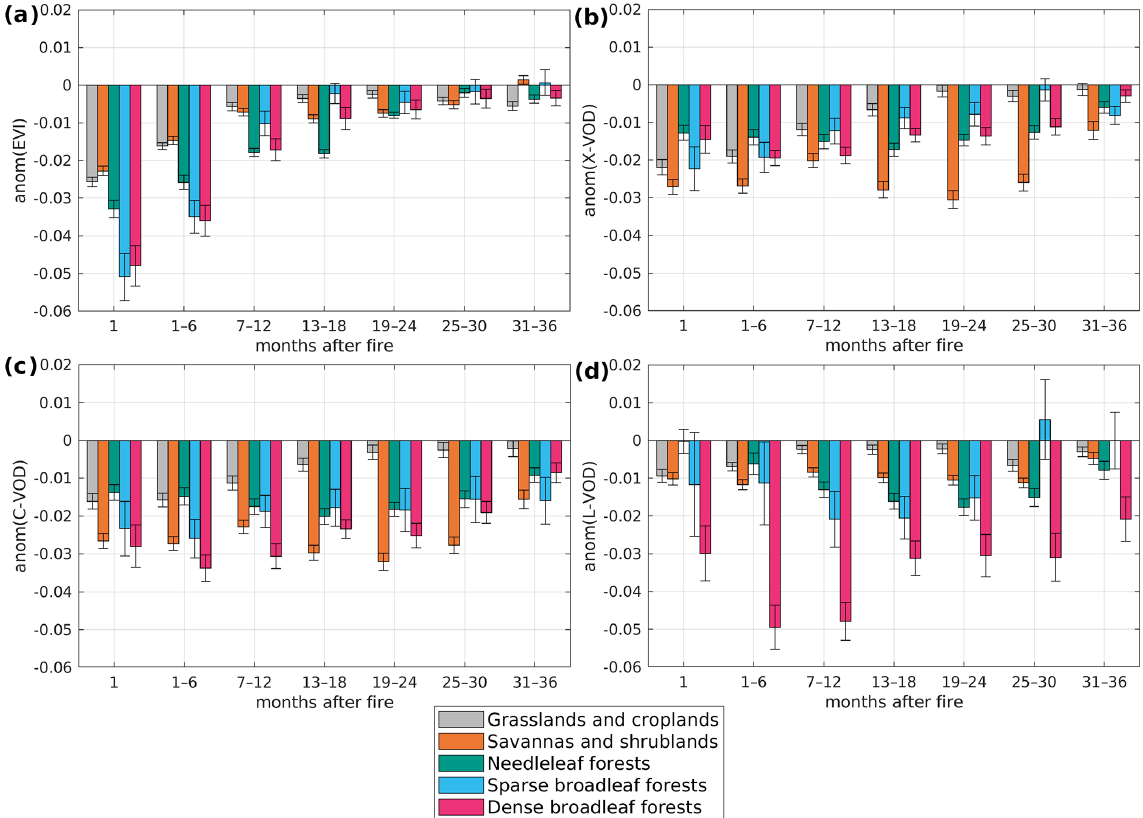
Figure 7. Anomalies of (a) EVI, (b) X-VOD, (c) C-VOD, and (d) L-VOD, for each ecosystem, at several post-fire timescales. The error bars were computed with Eq.